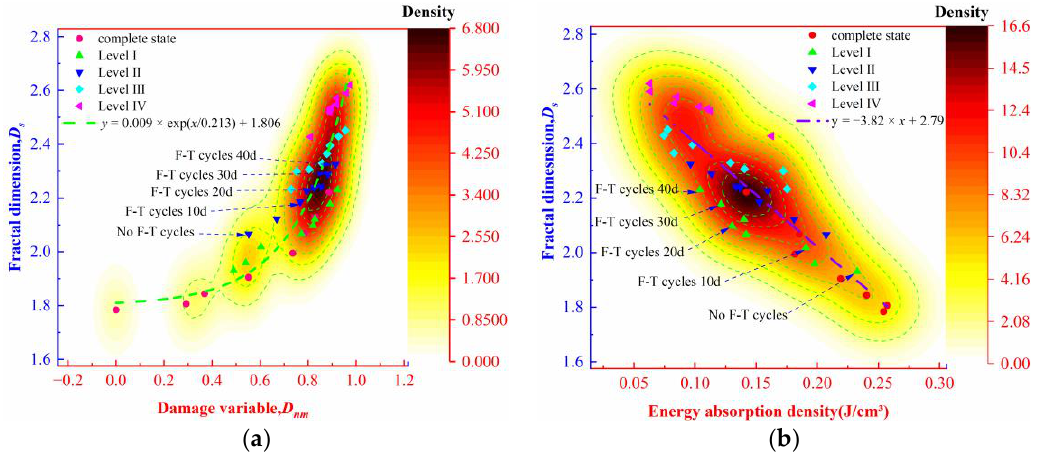
Figure 13. Density distribution of fractal dimension fragments: ( a ) Damage variable (D); ( b ) Energy absorption density.